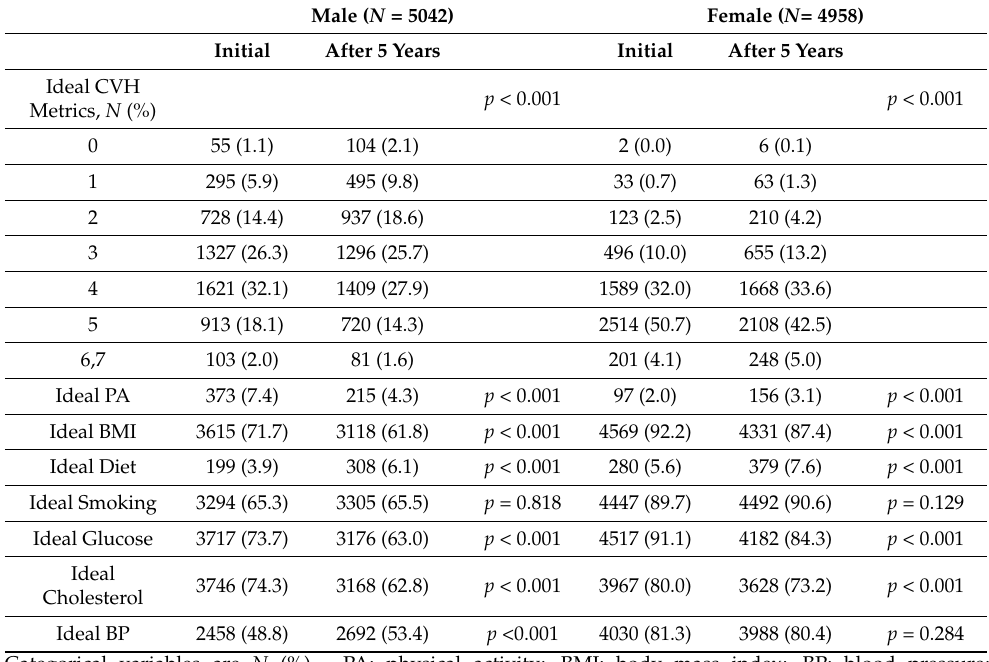
Table 2. Differences in ideal cardiovascular health metrics among the participants after 5